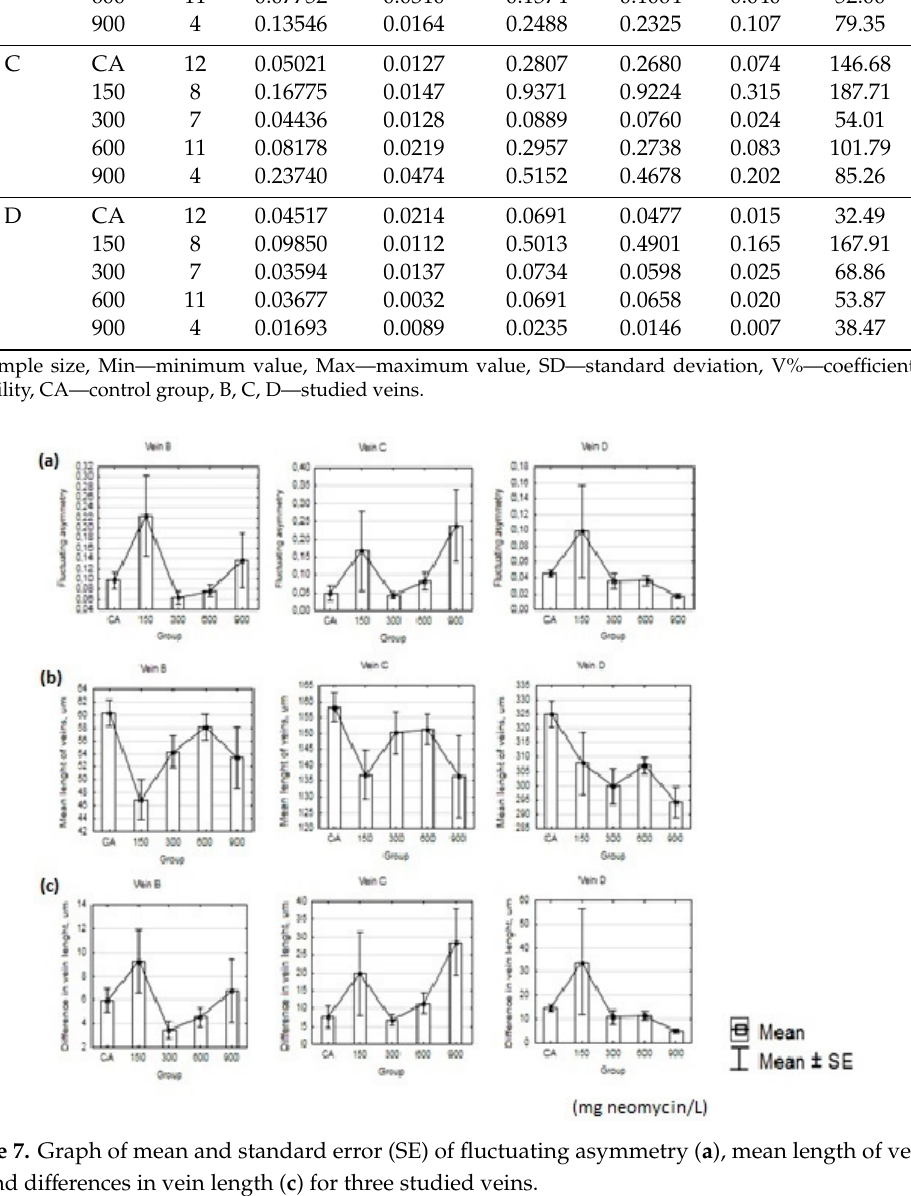
Figure 8. Graph of principal-component analysis for imagoes.